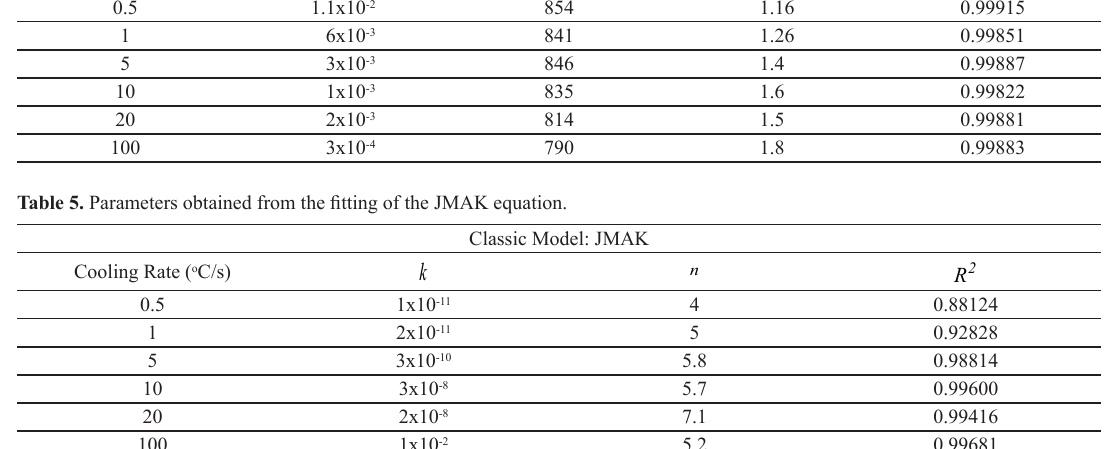
Table 4. Parameters obtained from the fitting of the Ferrite-Time equation. Proposed Equation: Ferrite-Time